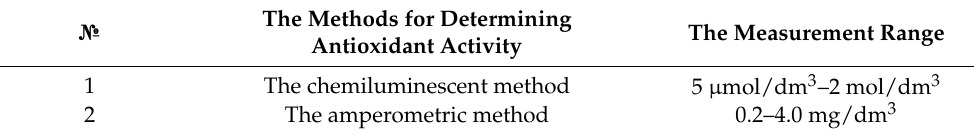
Table 1. The methods for determining antioxidant activity and their limits of detection.